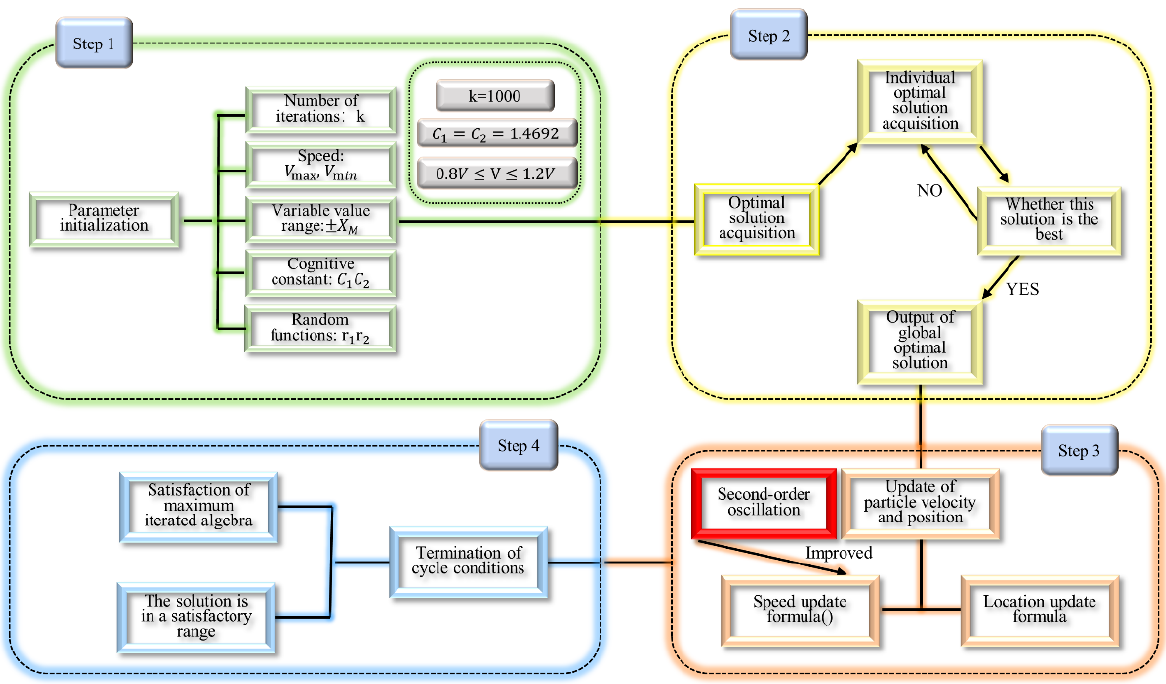
Figure 15. Particle swarm algorithm vector demonstration map.